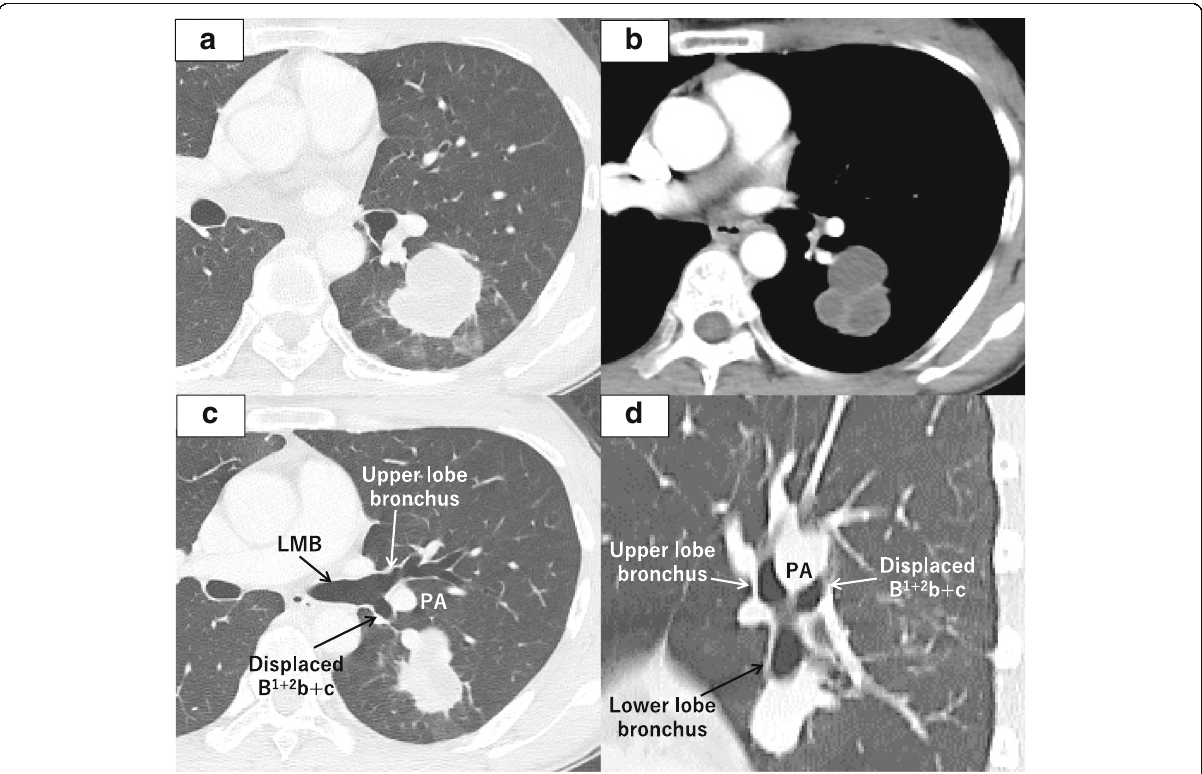
Fig. 1 Chest computed tomography. There is a multicystic mass with a diameter of 35 mm on the dorsal interlobar parenchyma between the S 1+2 and S 6 segments in the left lung ( a , b ). The displaced bronchus arises from the left main bronchus and passes to the dorsal side of the left main pulmonary artery ( c , d ). LMB, left main bronchus; PA, pulmonary